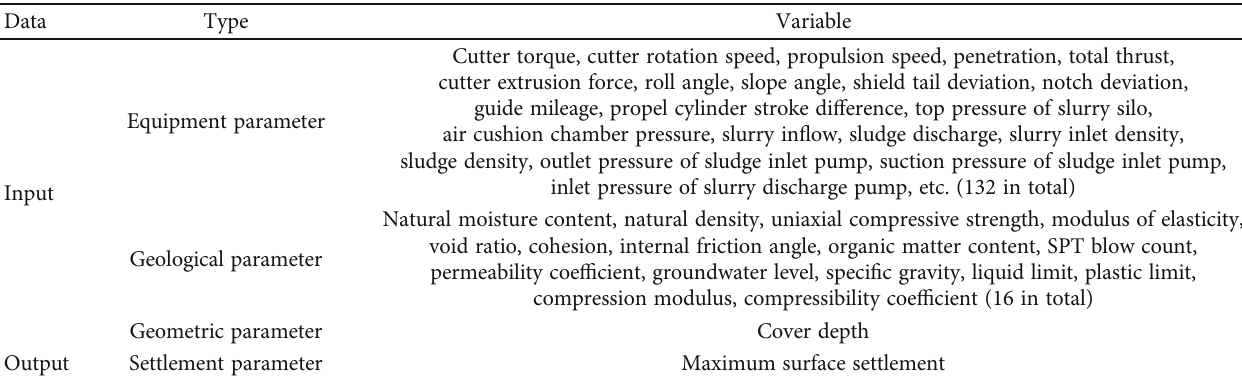
Figure 2: Chunfeng tunnel geological pro fi le. Table 1: Parameters of the project.